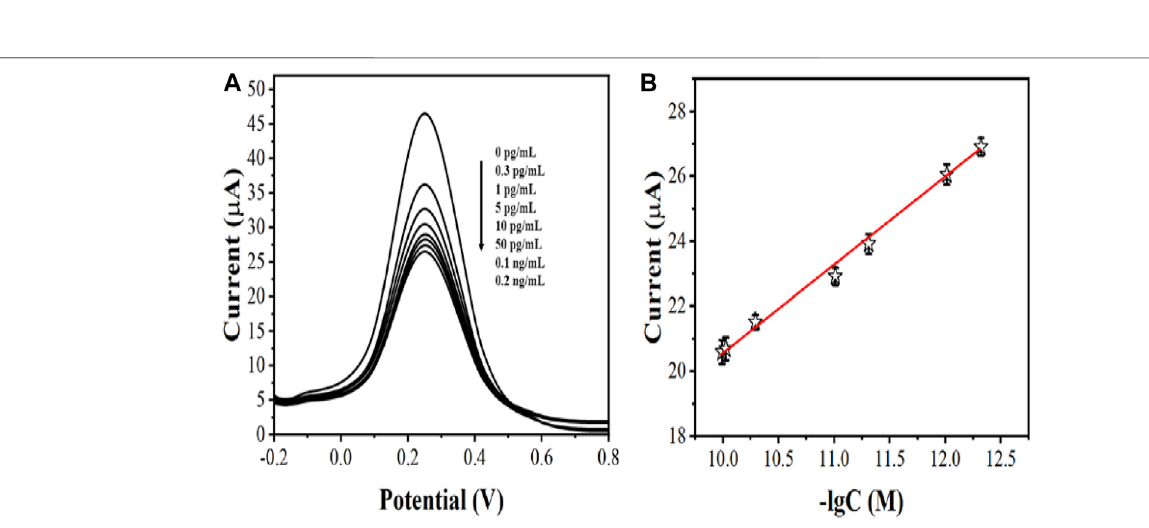
Frontiers in Chemistry |